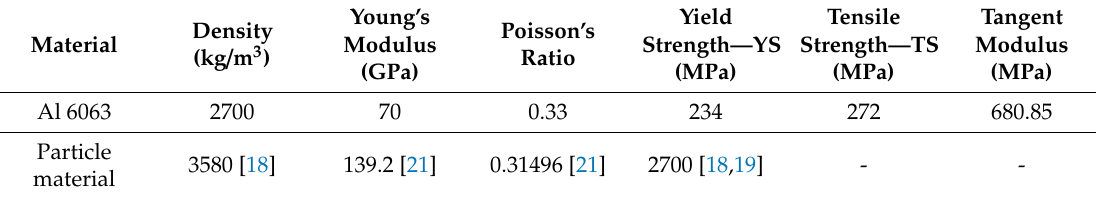
Figure 3. Generated mesh: ( a ) Particle mesh and ( b ) Aluminum body mesh. Table 1. Mechanical properties used in the FE